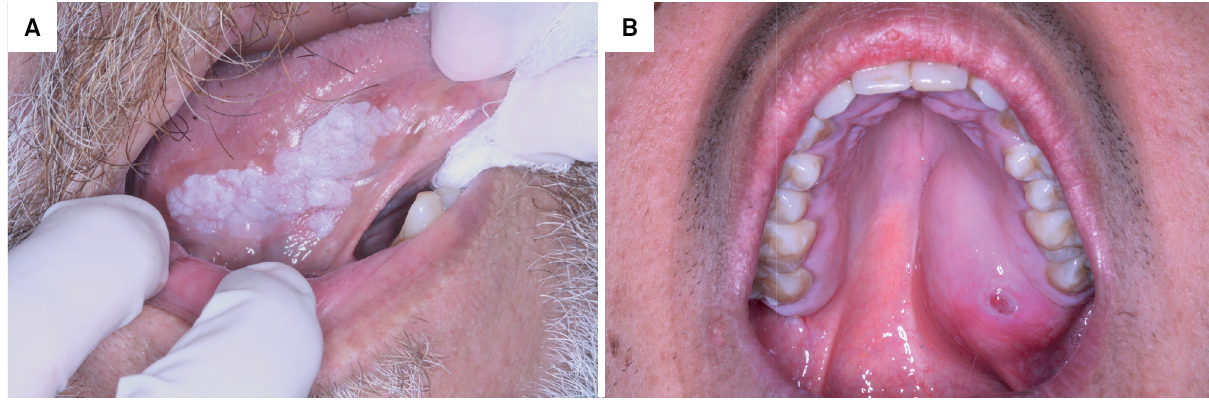
Figure 1. Images of the lesions presented to the participants during the description process. Lesion A: leukoplakia. Lesion B: benign tumor of salivary gland. Source: Oral Pathology/UFSC